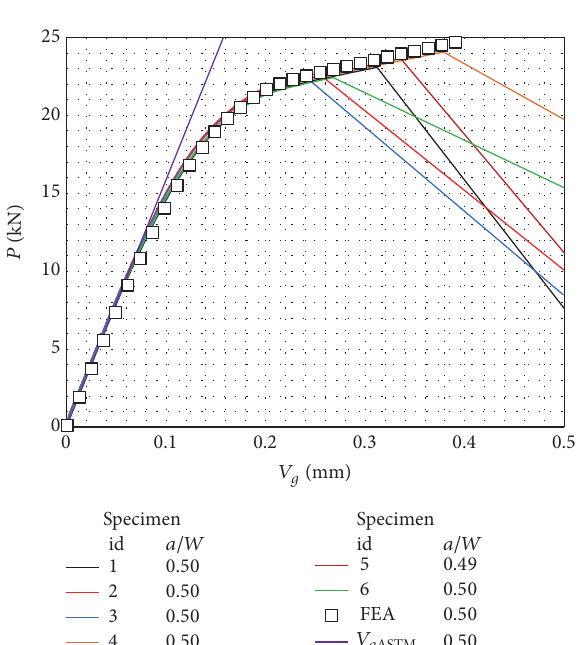
Figure 6: Comparison of the 𝑃 - 𝑉 𝑔 diagrams of the 25t SE(B) specimen: EP-FEA results shown with open rectangles show good agreement with the experimental results (S55C, 20 ∘ C).